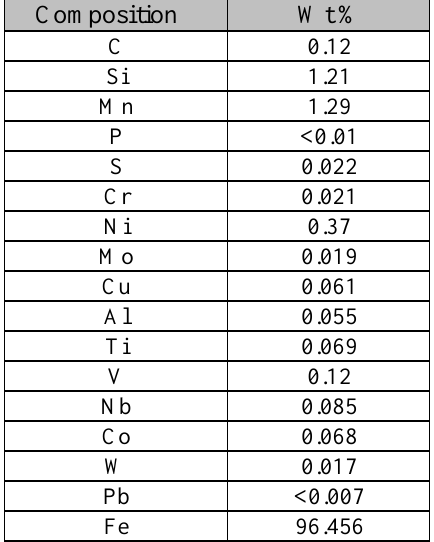
Table 3: Chemical components of steel (low carbon steel).